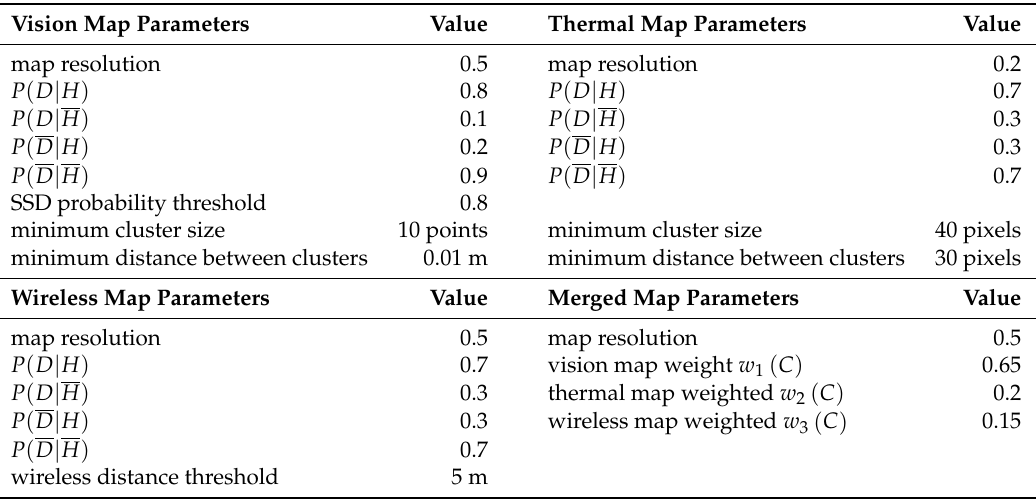
Table 4. Parameters used in the